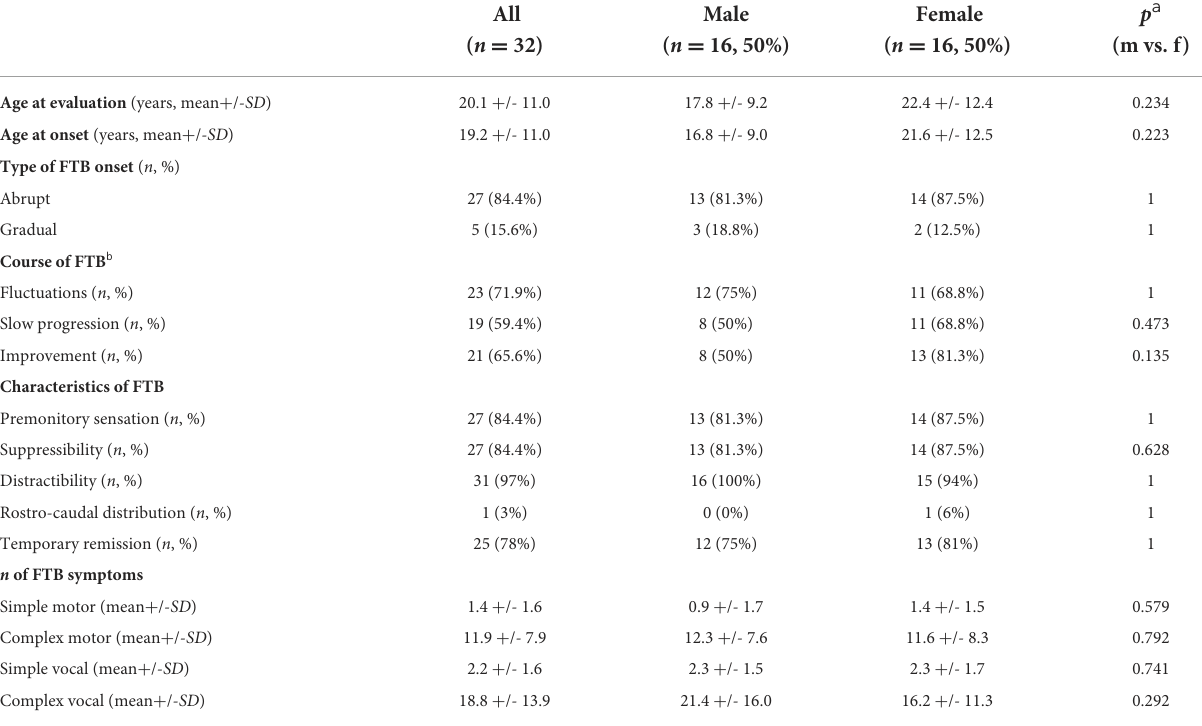
TABLE 1 Clinical characteristics in patients with MSMI-FTB including comparison between males and females.